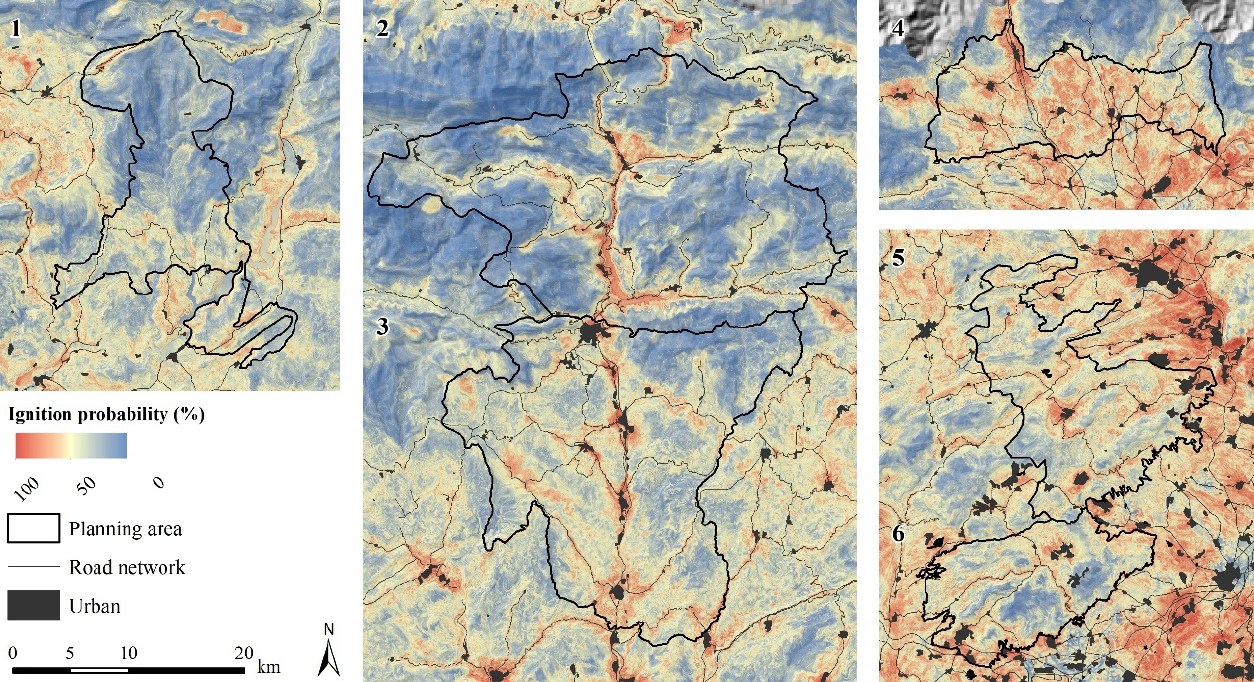
Figure 3. High resolution (40 m) ignition probability grid generated from fire ignitions (1998 to 2015; Figure 1B) and geospatial features using Random Forest. The numbers refer to the planning area codes (Appendix A; Figure 1).